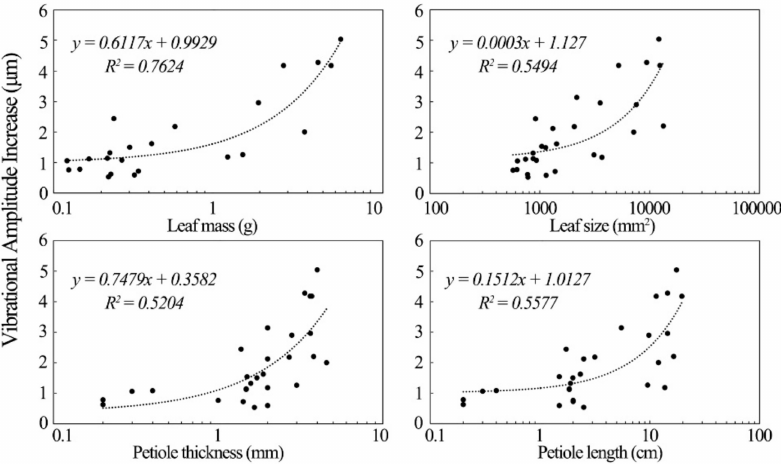
Figure 7. Factors influencing increases in leathery plant leaf vibration.